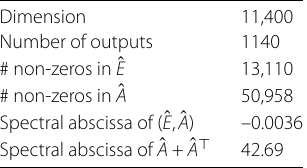
Table 1 Properties of stochastic Galerkin system in mass-spring-damper example